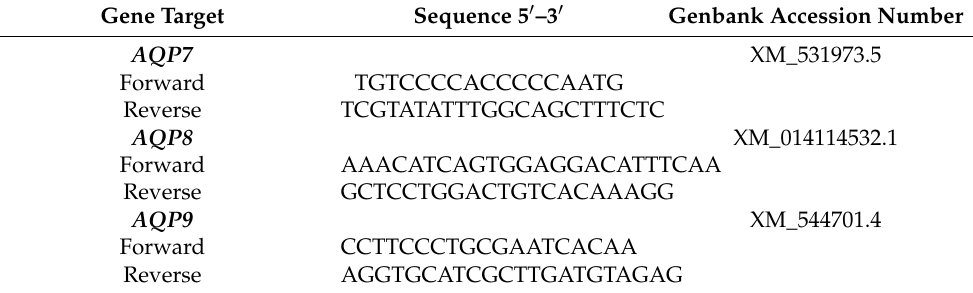
Table 1. Primers for real-time